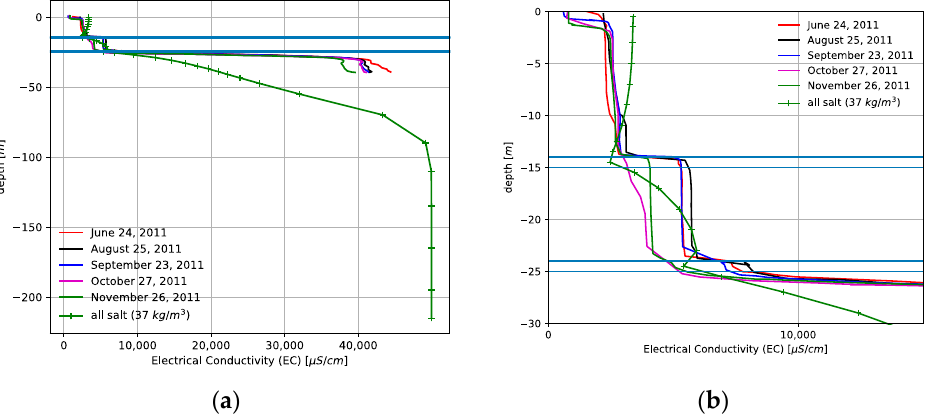
Figure 16. ( a ) Comparison of the EC profile with a numerical simulation where the whole three-dimensional grid is filled up with a salt concentration of 37 kg/m 3 . The cross-section is at the row 16 and the column 305; ( b ) a zoom in the region of interest. Notice that due to the hydraulic conductivity the salt is pushed away in the direction toward the sea. It is observed the two-steps shape.